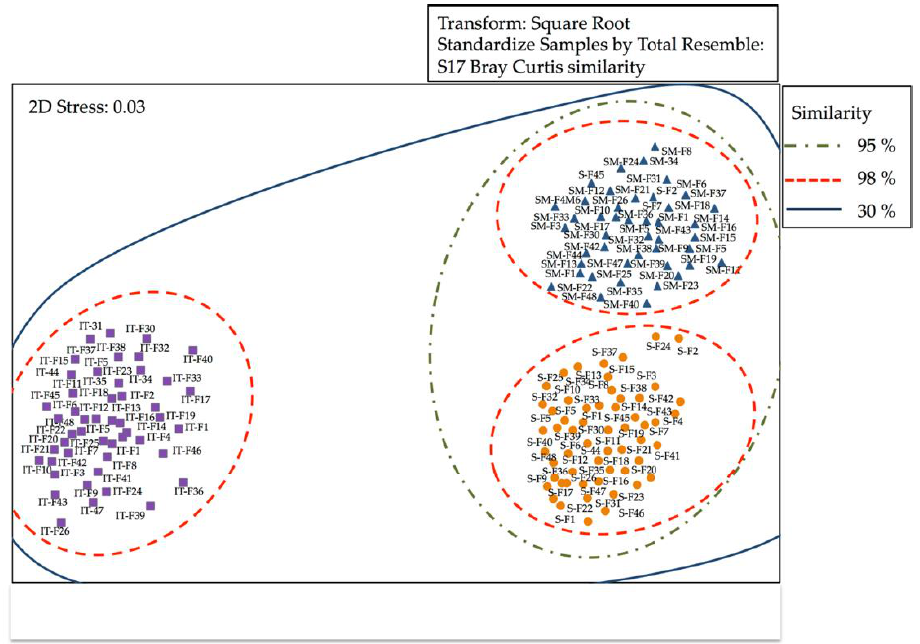
Figure 1. Multidimensional scaling (MDS) of the denaturing gradient gel electrophoresis (DGGE) data matrix of bacterial 16s rRNA from D. eleginoides . Stomach (S); skin (SM); intestine (IT).